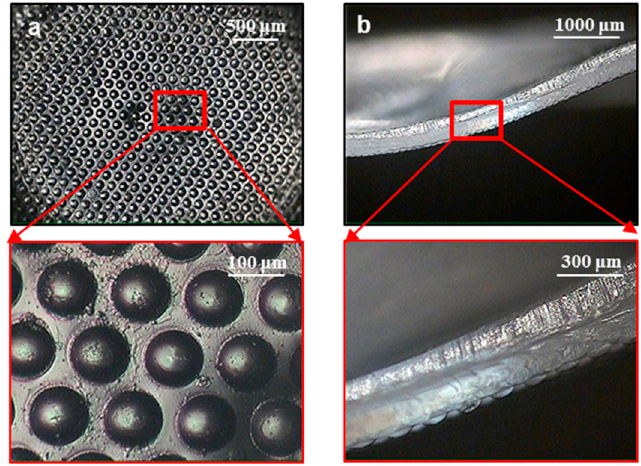
Figure 9. Microscopic images of the dot micropatterns on a curved surface: ( a ) bottom view; ( b ) sectional view.